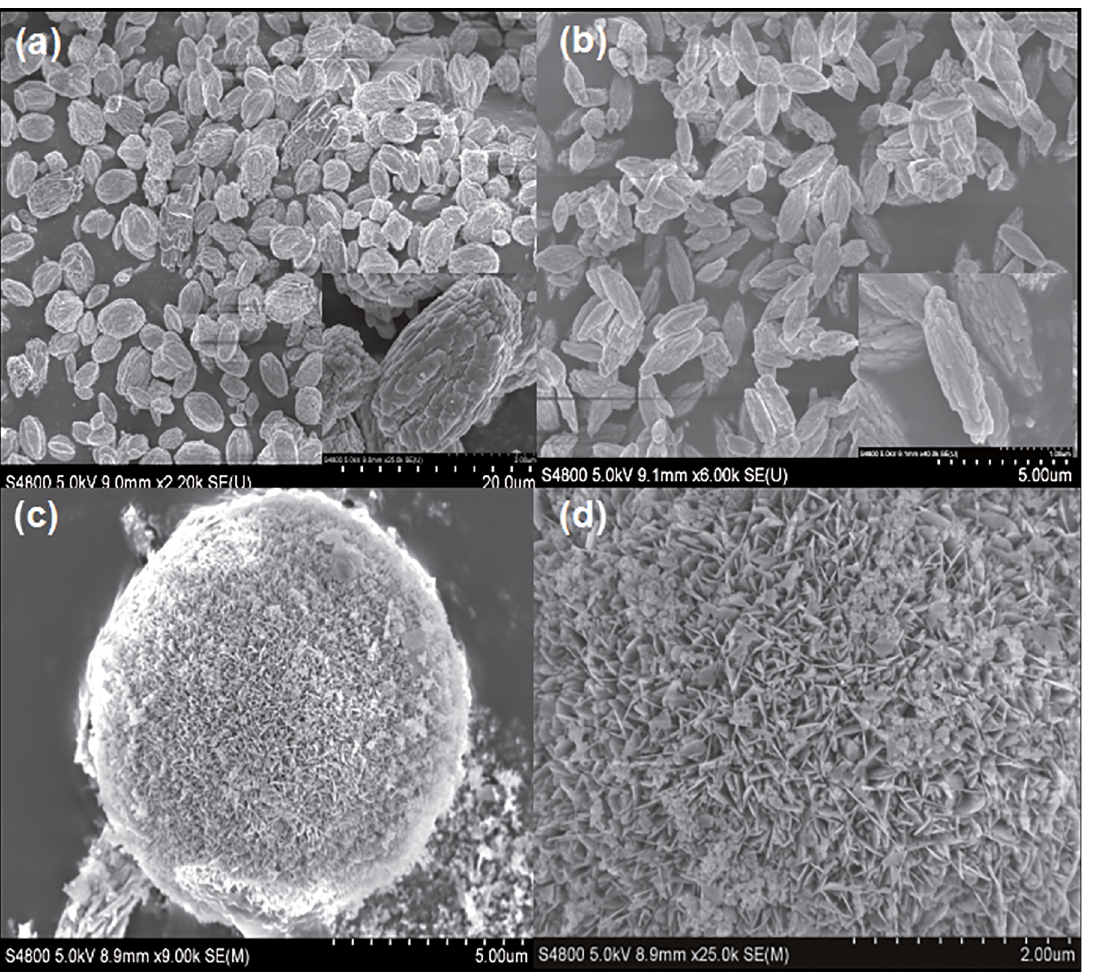
(OH)PO prepared from three different types of cupric salts as raw materials (a) 2 4 COO) •H O 3 2 2